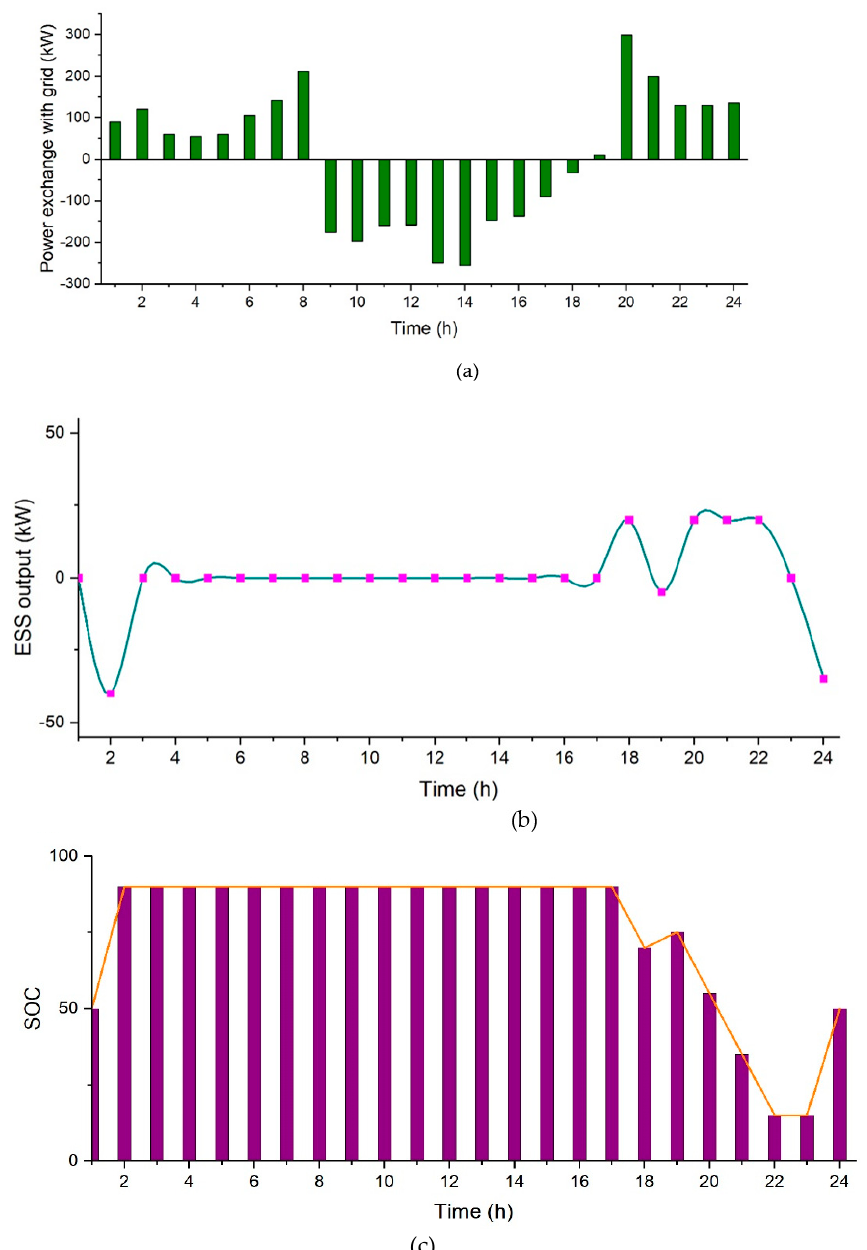
Figure 12. Case 4 (II), ( a ) Power exchange with the grid, ( b ) Power output of ESS , and ( c ) State of charge of battery. Table 4. Comparison of electricity cost for each case.